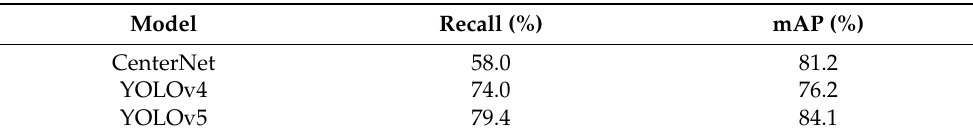
Table 3. Comparison of recall and mAP between CenterNet, YOLOv4, and YOLOv5 deep- learning algorithms. Model Recall (%) mAP (%)